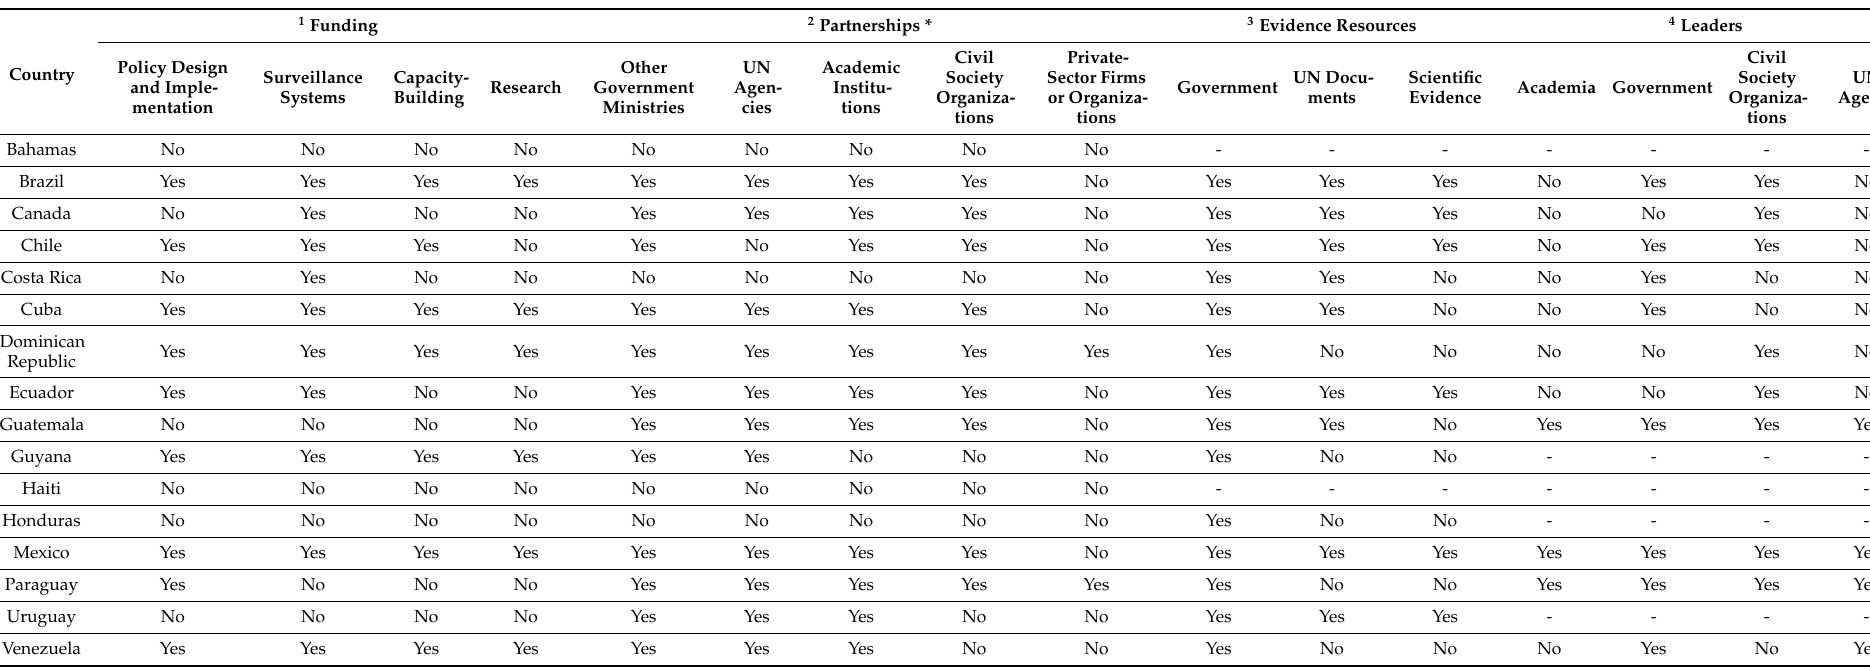
Table 1. Capacity-building public health infrastructure characteristics to restrict the marketing of HFSS food and non-alcoholic beverages in countries in the region of the Americas.